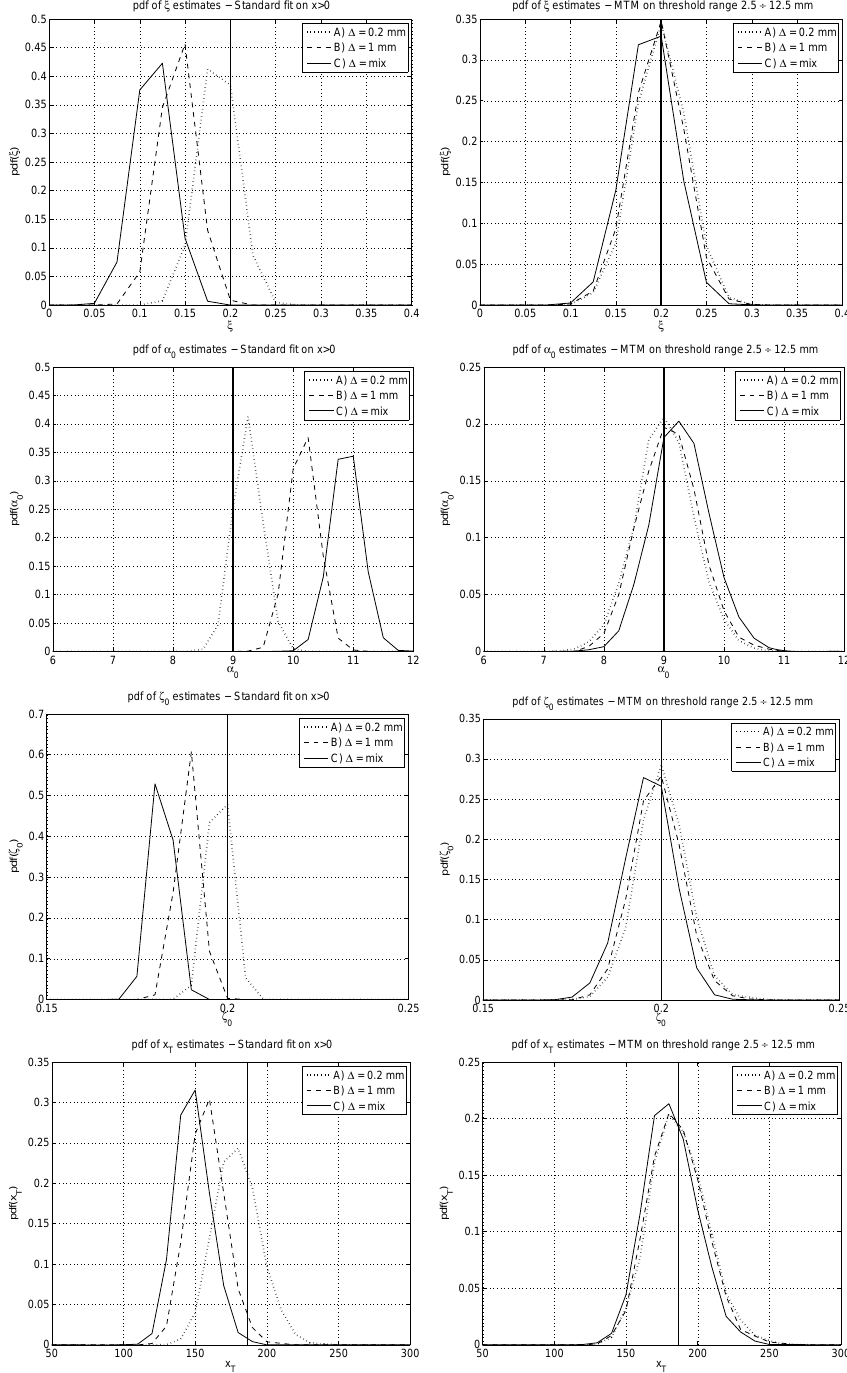
Fig. 7. Relative frequency distributions of ξ , α 0 and ζ 0 and corresponding 50-yr quantiles on 5000 GPD random samples discretized according to test A (resolution 1 = 0 . 2mm, dotted lines), B ( 1 = 1mm, dashed lines), and C (mixing of resolutions up to 1 = 5mm, solid lines). Results from the standard fit method with a single threshold u = 0 (all strictly positive records are used) and from the MTM applied in a range of thresholds between 2.5mm and 12.5mm are shown in the left and right column, respectively. From top to bottom, the plots display results for ξ , α , ζ 0 and 50-yr quantile estimates. Vertical thick solid lines show the parameters of Eq. (10) used for Monte Carlo simulations and the expected